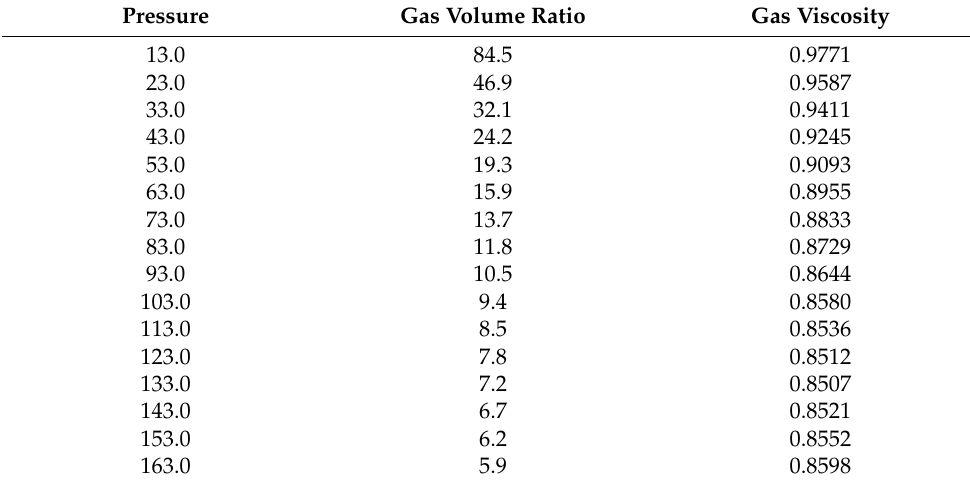
Table 3. PVT for gas (variant 1).